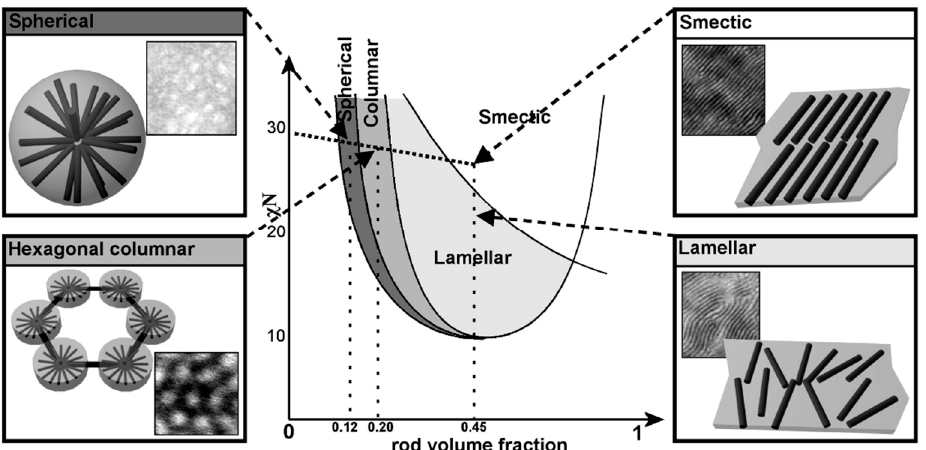
Figure 8. Comparison between the phase diagram predicted by Landau expansion theories for rod − coil block copolymers and the microphase-separated morphologies experimentally observed for PPV − P4VP block copolymers. (Reprinted with permission from Ref [92]. Copyright American Chemical Society).